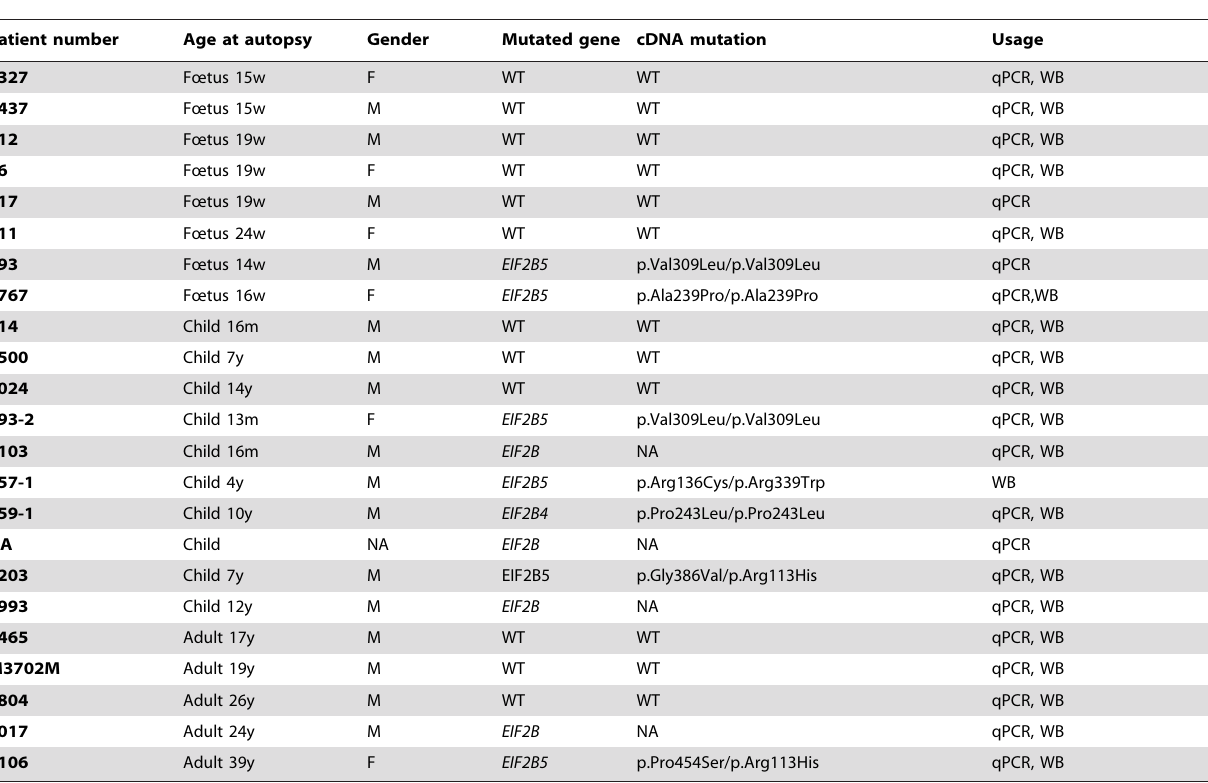
Table 4. Characteristics of brain samples used for microarray data validation on QRT-PCR (qPCR) and/or western blot (WB) analysis.